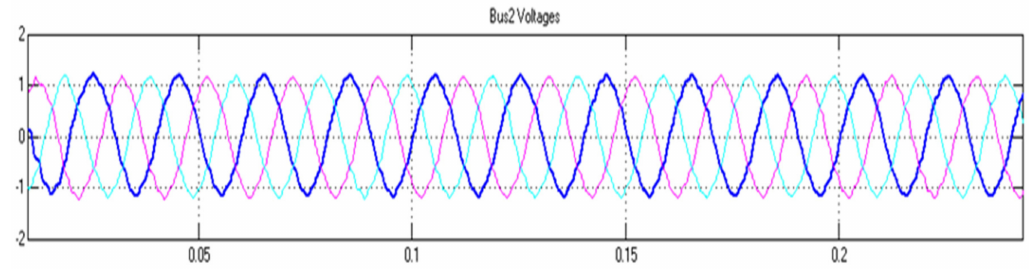
Figure 13. Three phase output voltage with